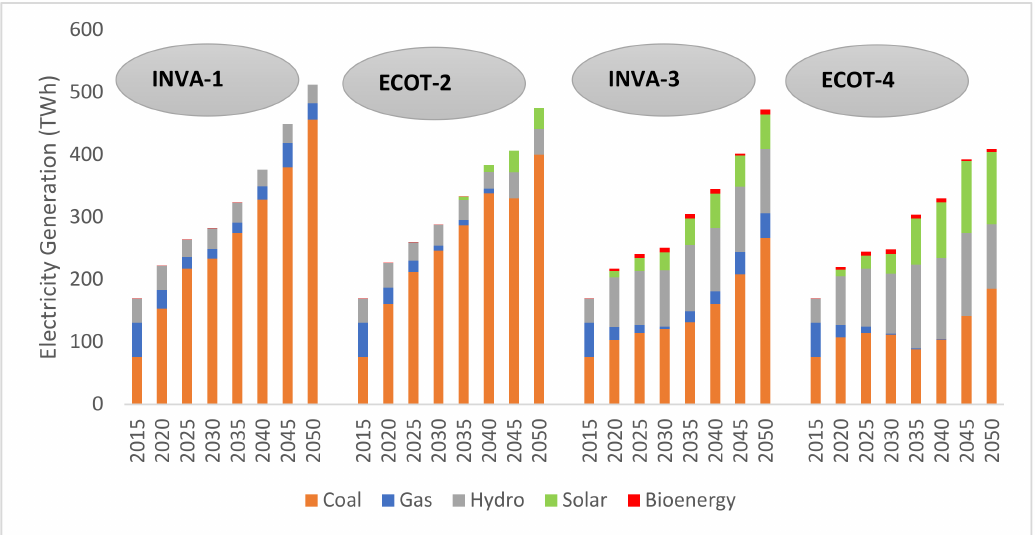
Figure 5. Electricity generation by technology under renewable energy policy consideration.